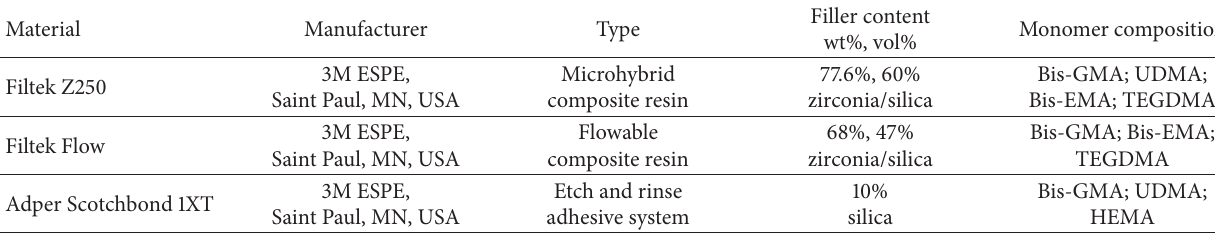
Table 1: Τ he materials used in the present study.